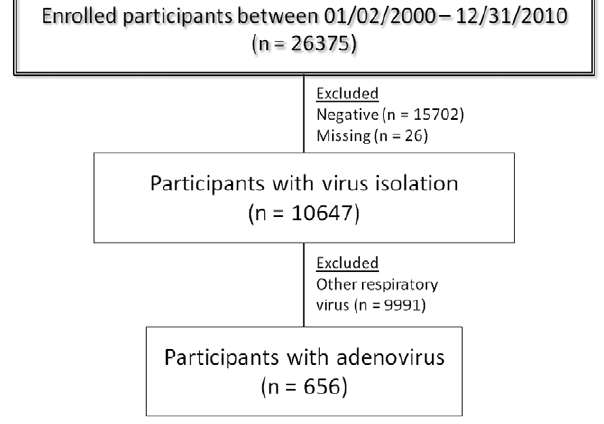
Figure 1. Flowchart for the analysis of patients with HAdv.